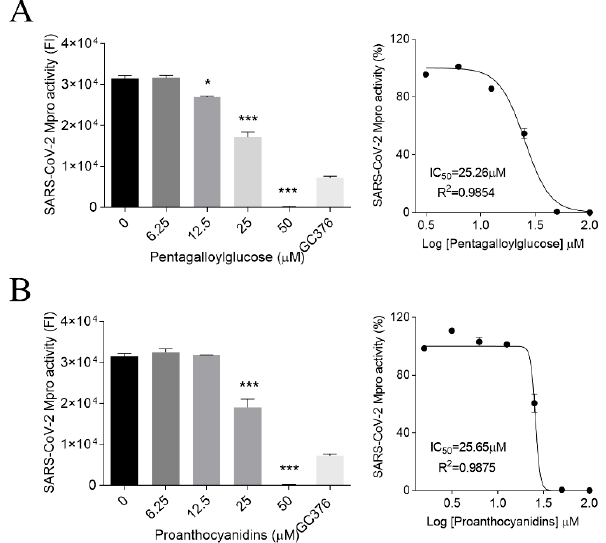
Figure 3. Inhibitory effect of PGG and PAC on the SARS-CoV-2 Mpro activity ( A , B ). PGG ( A ) and PAC ( B ) dose-dependently inhibited the Mpro activity of SARS-CoV-2 (left panel) (6.25~50 μ M), 100 µ M GC376 was used as a positive control. The IC 50 values are presented by nonlinear regression analysis (right panel). Statistical comparisons were conducted using one-way analysis of variance (ANOVA), followed by Bonferroni’s multiple comparison test. * p < 0.05; *** p < 0.001 vs. 0 µ M. The data represent triplicate experiments, and are presented as the mean ±